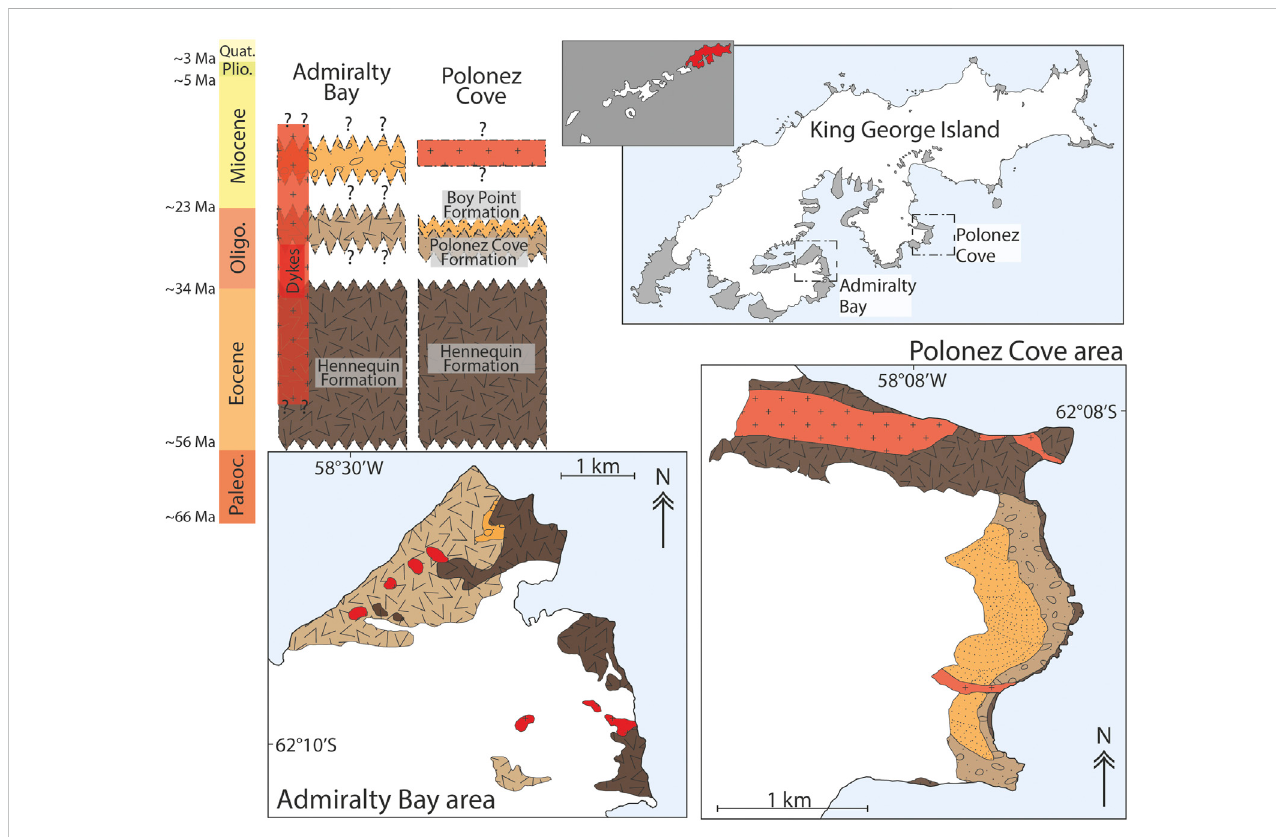
FIGURE 13 Geological map of Admiralty Bay and Polonez Cove areas modi fi ed from Smellie et al. (1984); Smellie et al.